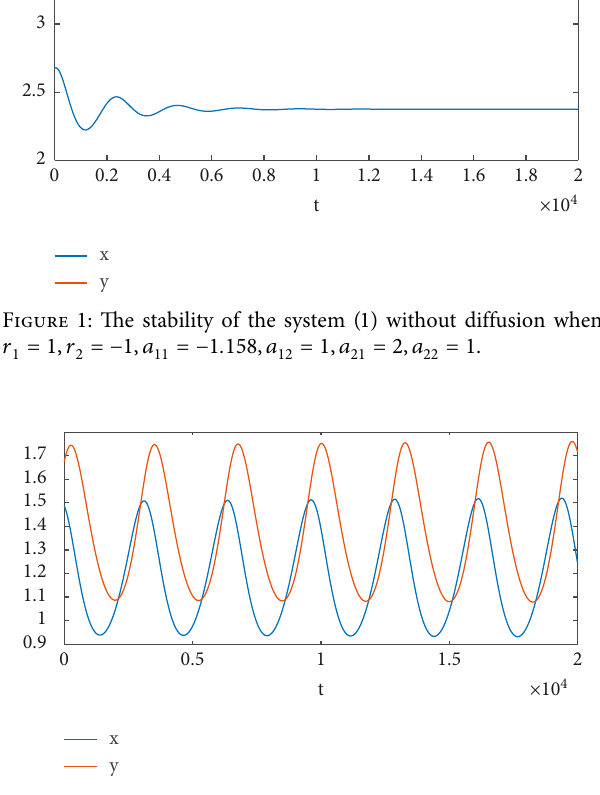
Figure 2: The stability of the system (1) without diffusion when